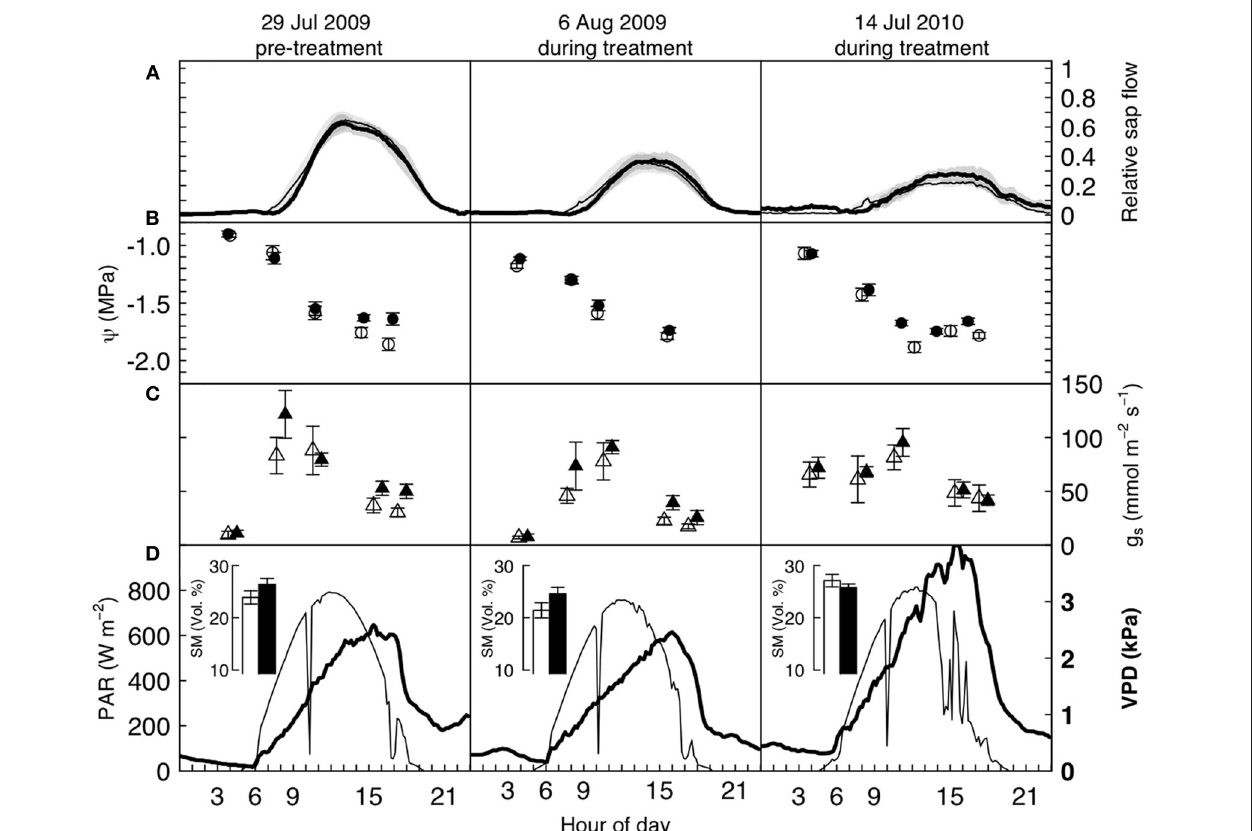
FIGURE 2 | Diurnal water relations data of mature P. abies trees under elevated (bold/filled symbols) and ambient (open symbols) atmospheric CO 2 , before and after the treatment was initiated, on three cloudless summer days in 2009 and 2010. Panels (A) show relative sap flow (each tree standardized to its pre-treatment maximum, n = 5), panels (B) and (C) show mean leaf water potentials and stomatal